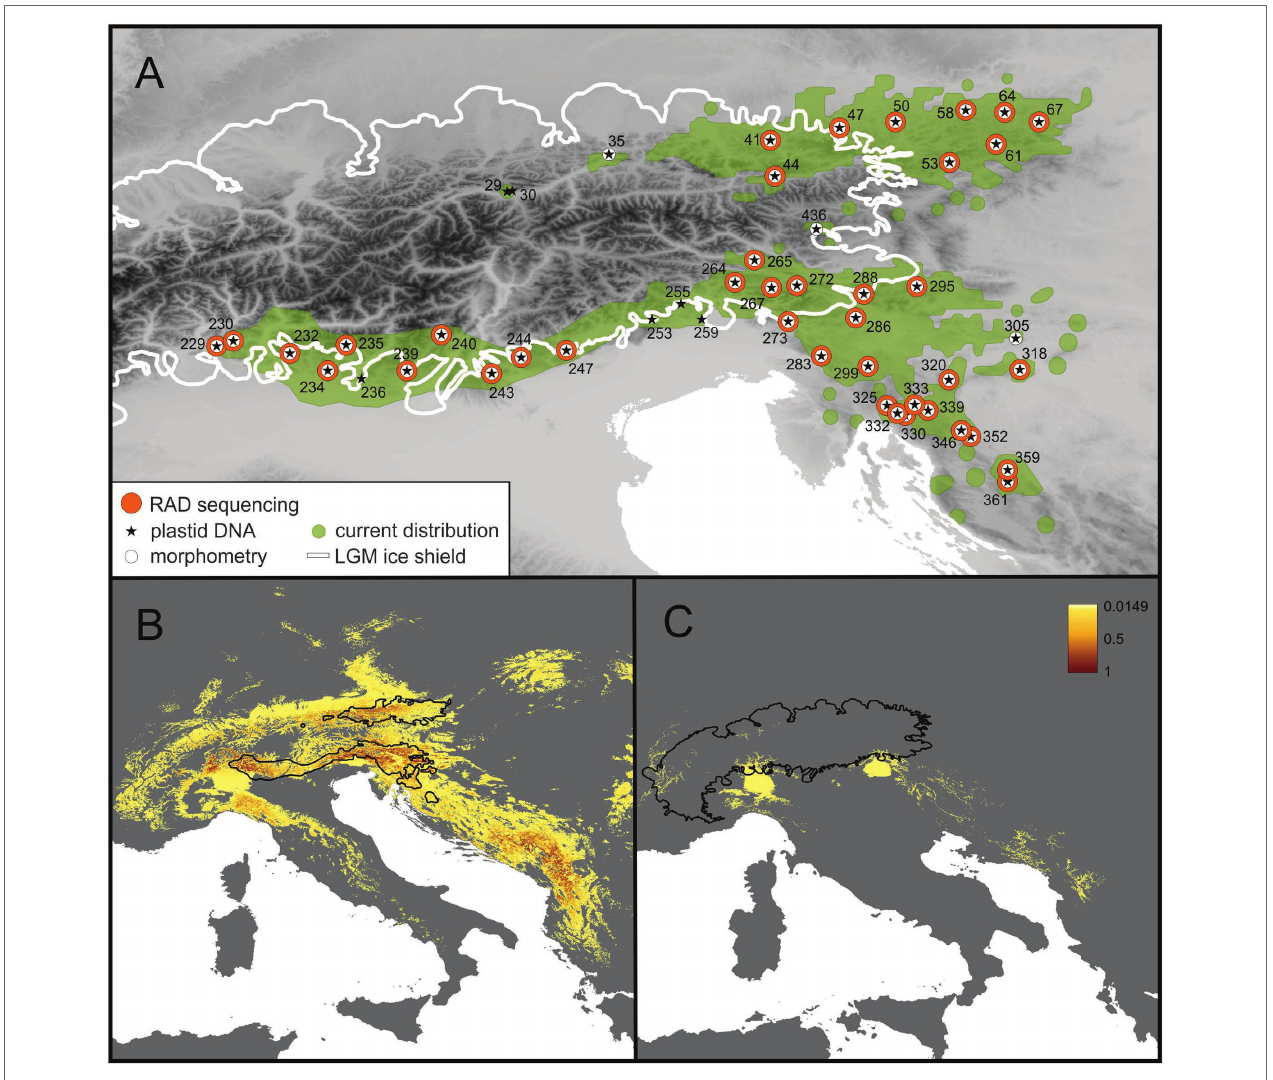
FIGURE 1 | Current distribution and sampled populations of H. niger (A) as well as the potential distribution at present (B) and at the Last Glacial Maximum (LGM; C ). (A) Current distribution (green), extent of glaciation during the LGM (white line) and sampled populations (numbered). Symbols indicate if a population was used for RADseq (orange dots), plastid DNA sequencing (stars), or morphometry (white dots). Locality information is detailed in Supplementary Table 1 . (B,C) The occurrence probability derived from species distribution models (SDMs) is indicated by a color shade ramp; the terrestrial surface with occurrence probability <0.05 is in gray. In (B,C) the current distribution and the LGM glaciation of the Alps, respectively, are indicated by black